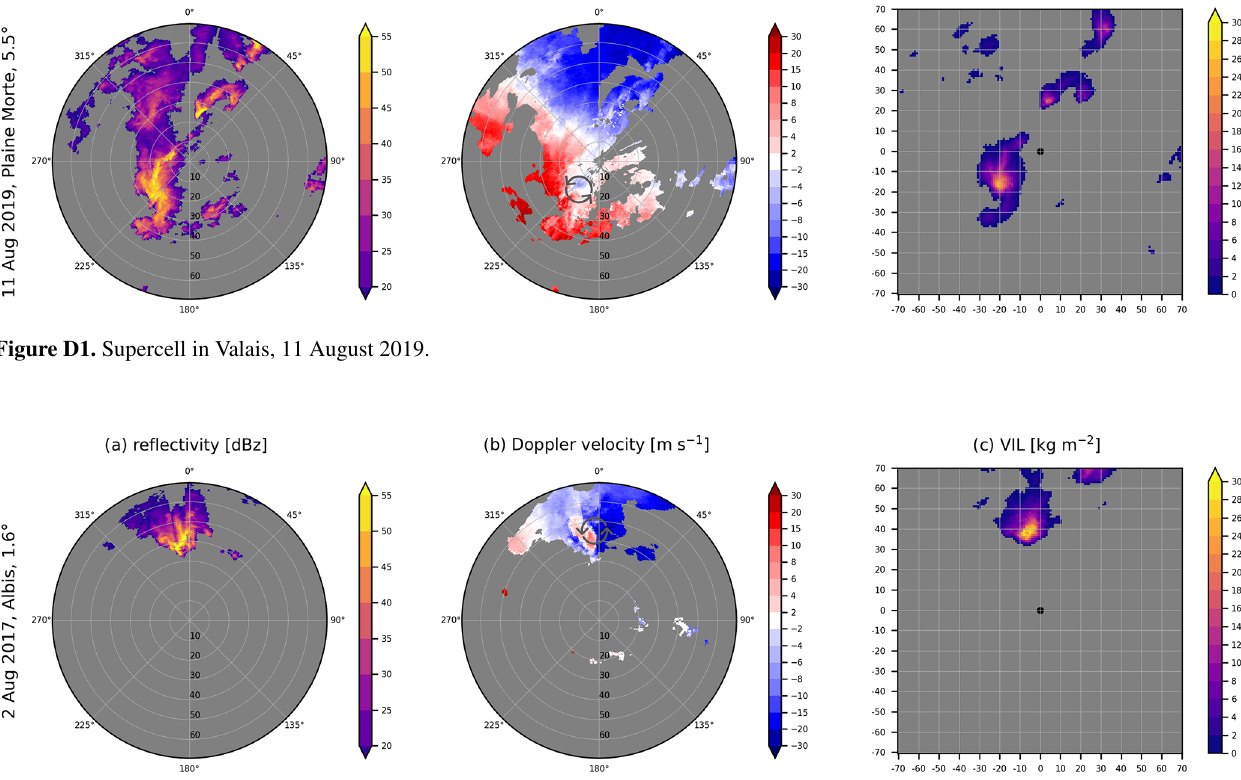
Figure D2. Supercell along the Rhine Valley, 2 August